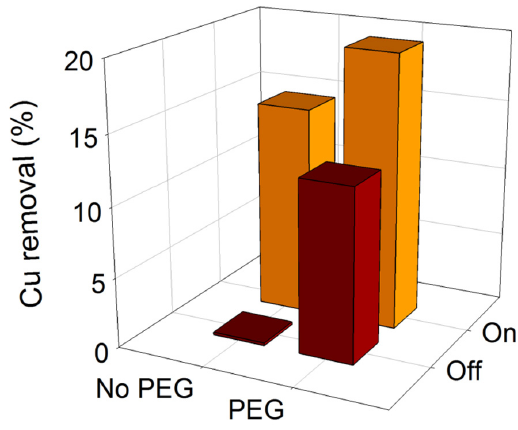
Figure 7. Copper removal for the 1 layered TiO under